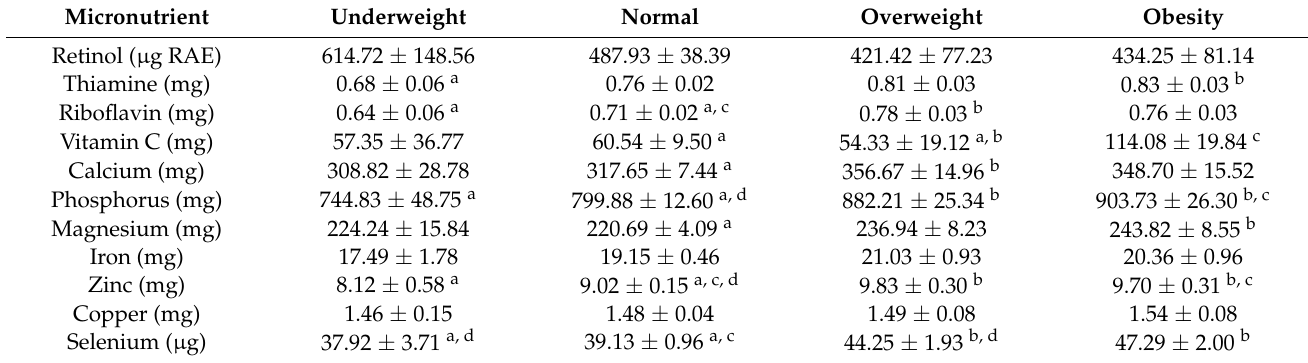
Table 2. Estimated daily micronutrient intakes from foods by category of body weight in boys aged 6–17 years, CHNS 2015 ( n = 806) 1